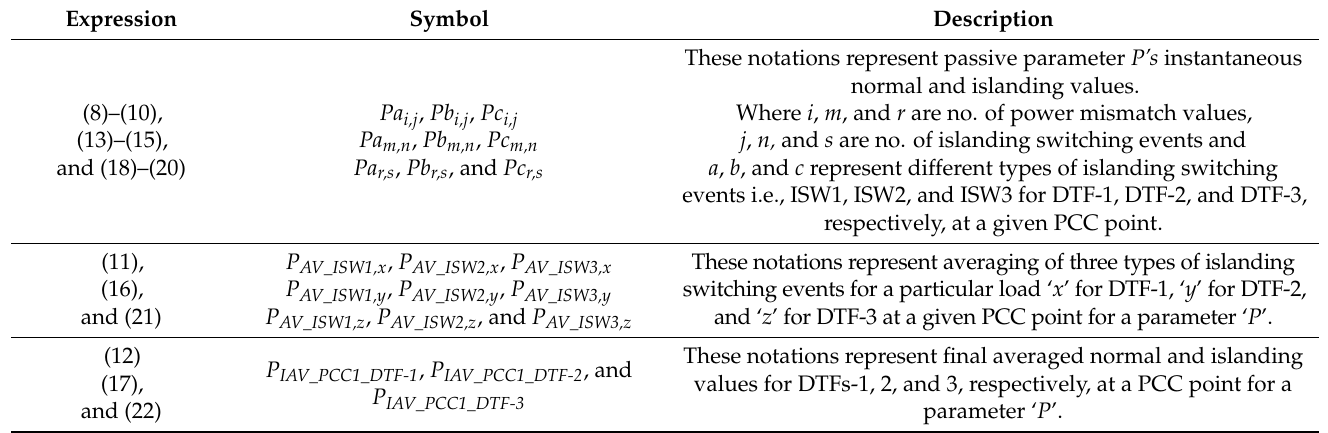
Table 5. Description of symbols used in the expressions for the computation of averaged islanding